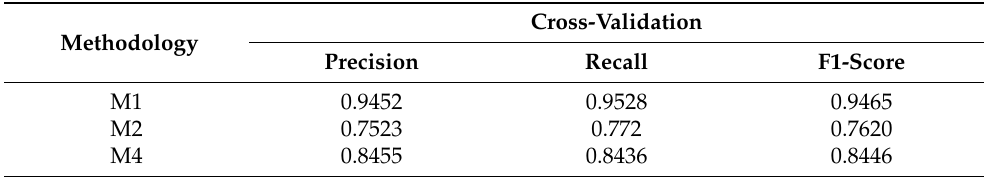
Table 6. Comparison of methodologies on Pattern